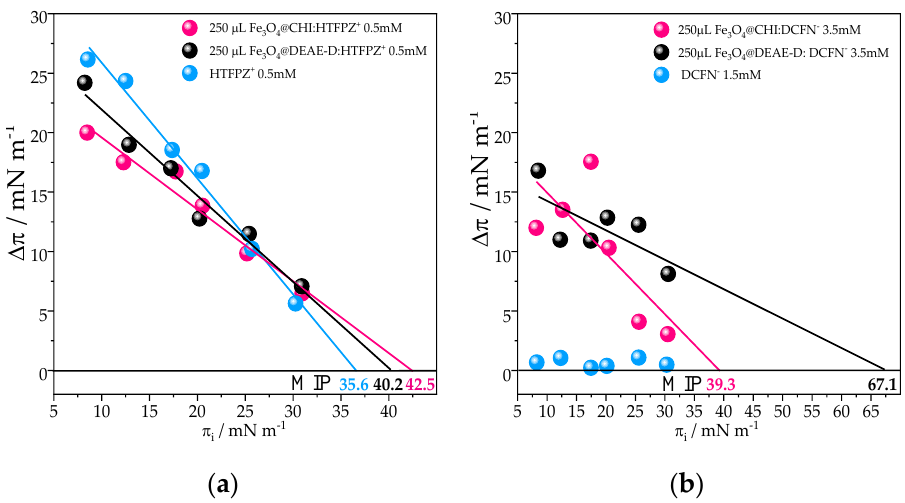
Figure 5. Linear plot of the increment in surface pressure as a function of the initial surface pressure of the DSPA monolayer after ( a ) MNPs:HTFPZ + and ( b ) MNPs:DCFN − injection in the subphase. x tangent intercept provides the MIP value.